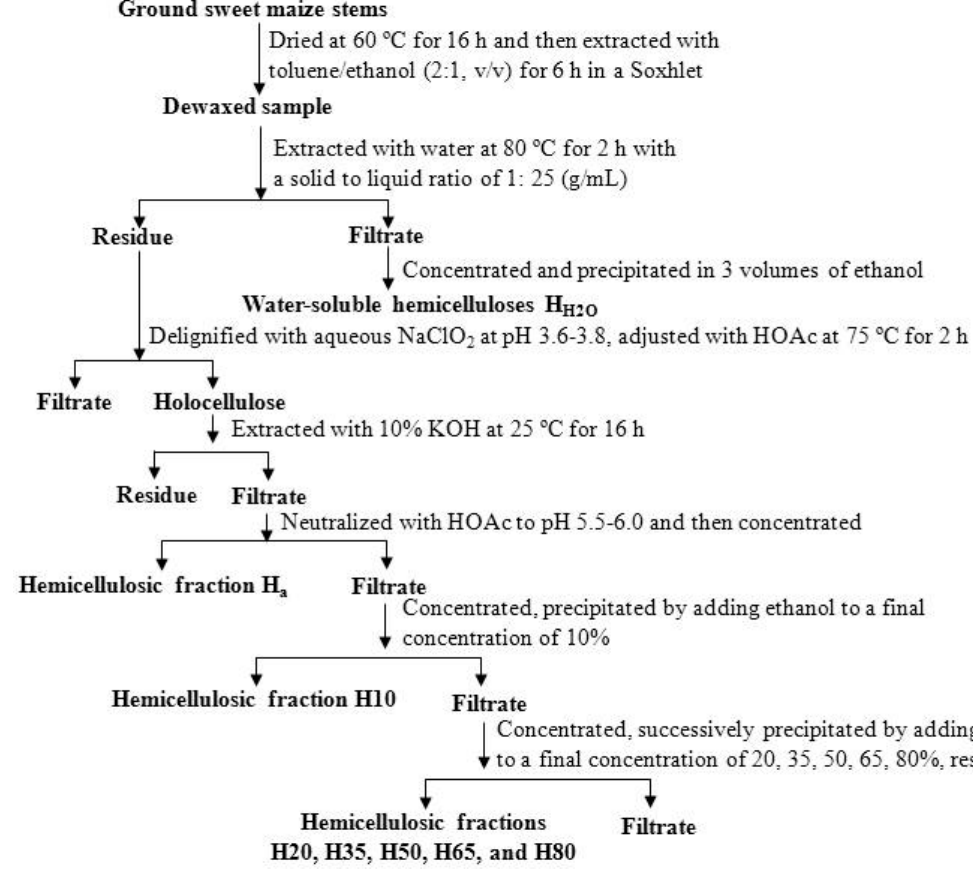
Figure 1. Scheme of hemicellulose fractionation from sweet maize stems.